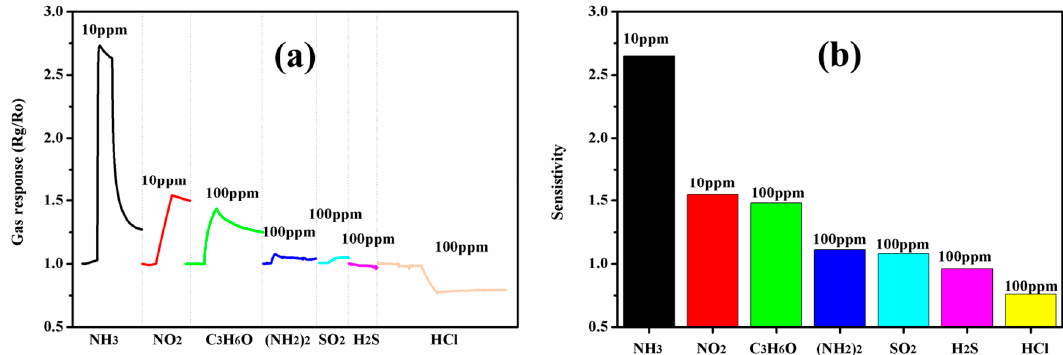
Figure 11. The sensing responses of the sensor based on the PANI nanotubes to NH 3 (10 ppm), NO 2 (10 ppm), C 3 H 6 O (100 ppm), NH 2 NH 2 (100 ppm), SO 2 (100 ppm), H 2 S (100 ppm), and HCl (100 ppm). ( a ) The real time patterns; ( b ) gas responses contracts.